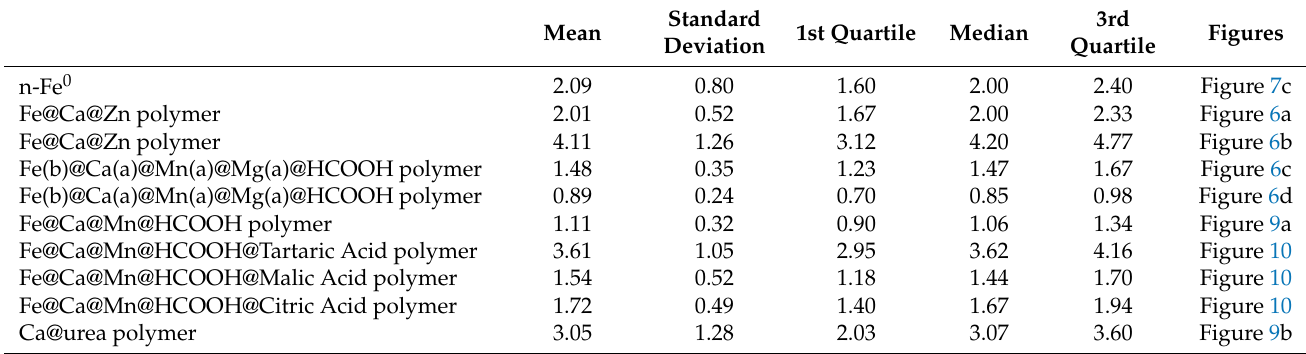
Table 1. Example measured pre-aggregation colloidal sphere sizes (microns) associated with the colloids illustrated or analysed in Figures 6, 7, 9 and 10. Number of measurements for each set of data = 50 to